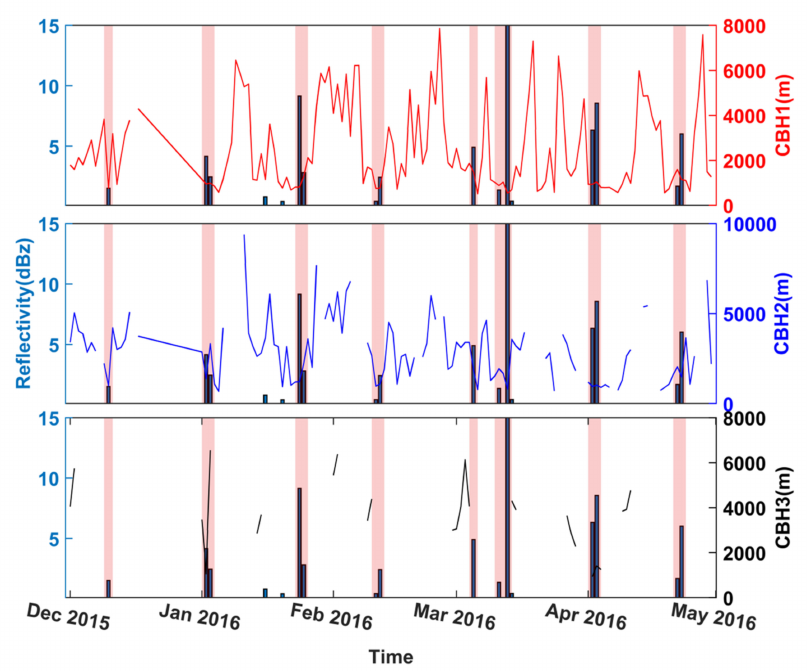
Figure 8. Radar reflectivity (dBz) from MRR2 vs. cloud base heights (meter) derived from ceilometer. The pink shaded regions represent moderate to heavy precipitation